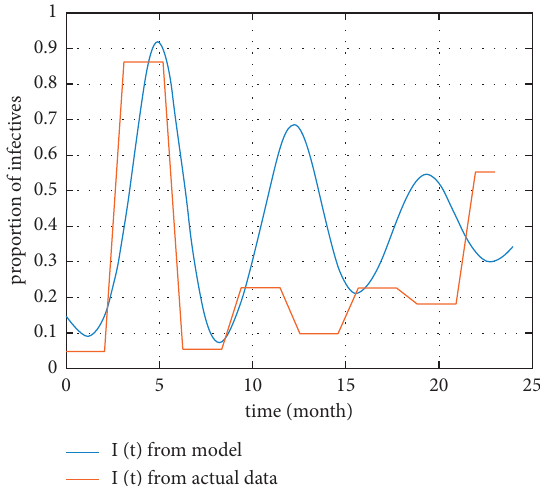
Figure 16: Proportion of infective curves from smoothing by bin medians data and the